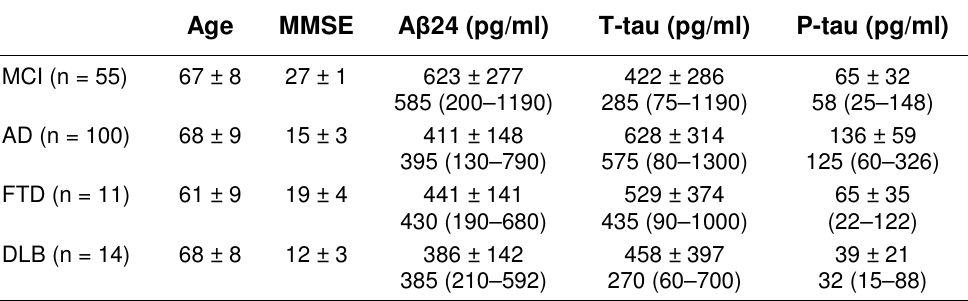
Values of CSF Biomarkers in All Groups at Baseline (Mean ± SD; Median,